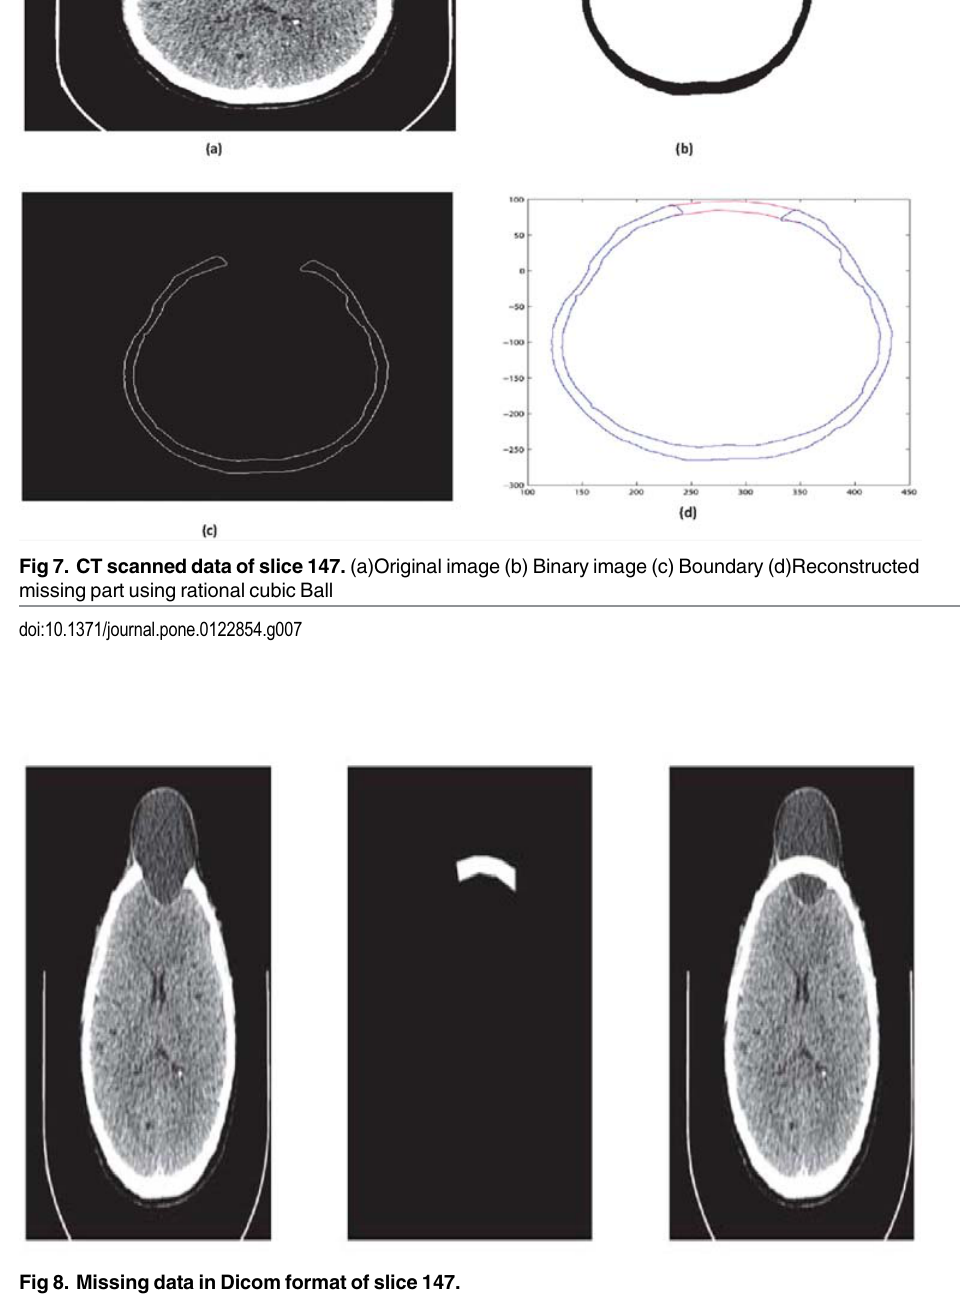
Fig 8. Missing data in Dicom format of slice